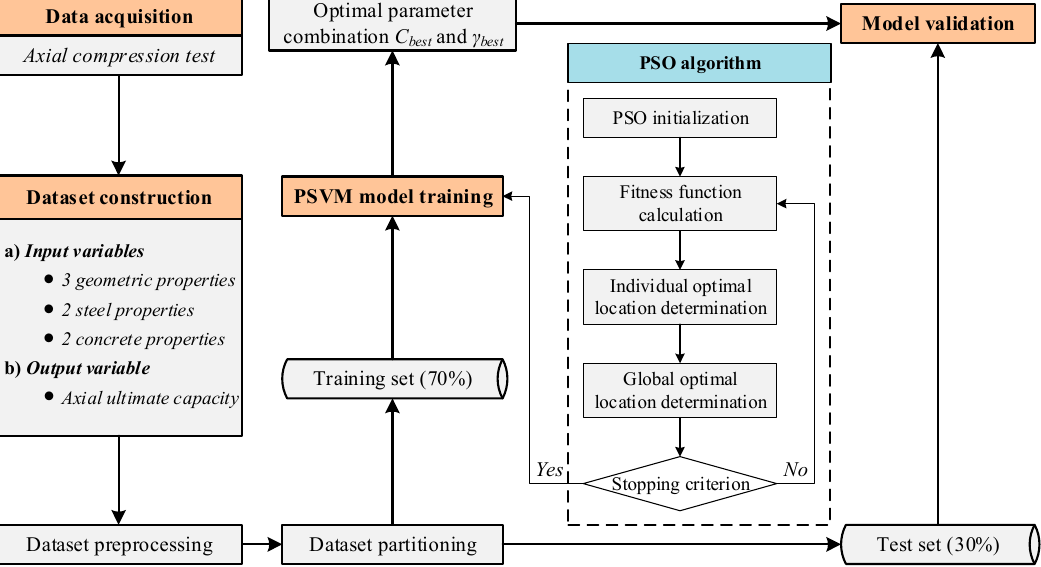
Figure 3. Correlation matrix of seven input variables. 4.2. Parameter Optimization The SVM parameters are optimized by means of both PSO and five-fold cross validation. The value ranges of two parameters C and γ were set as [0.1,100] and [0.01,100] , respectively.